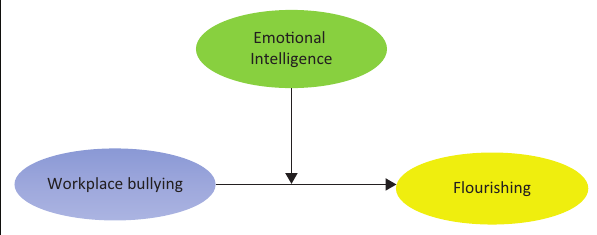
FIG URE 1: Emotional intelligence as a moderator of the relationship between workplace bullying and